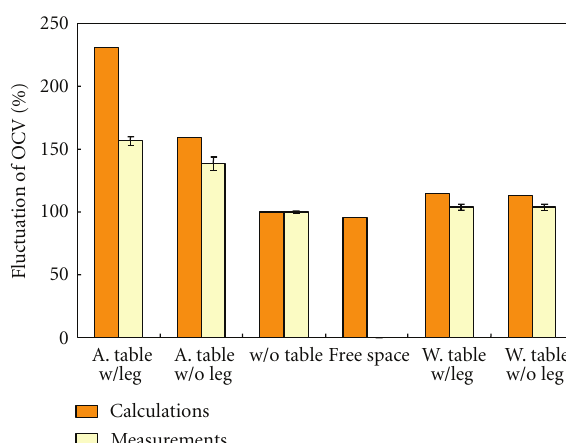
Figure 12: Measurement conditions.